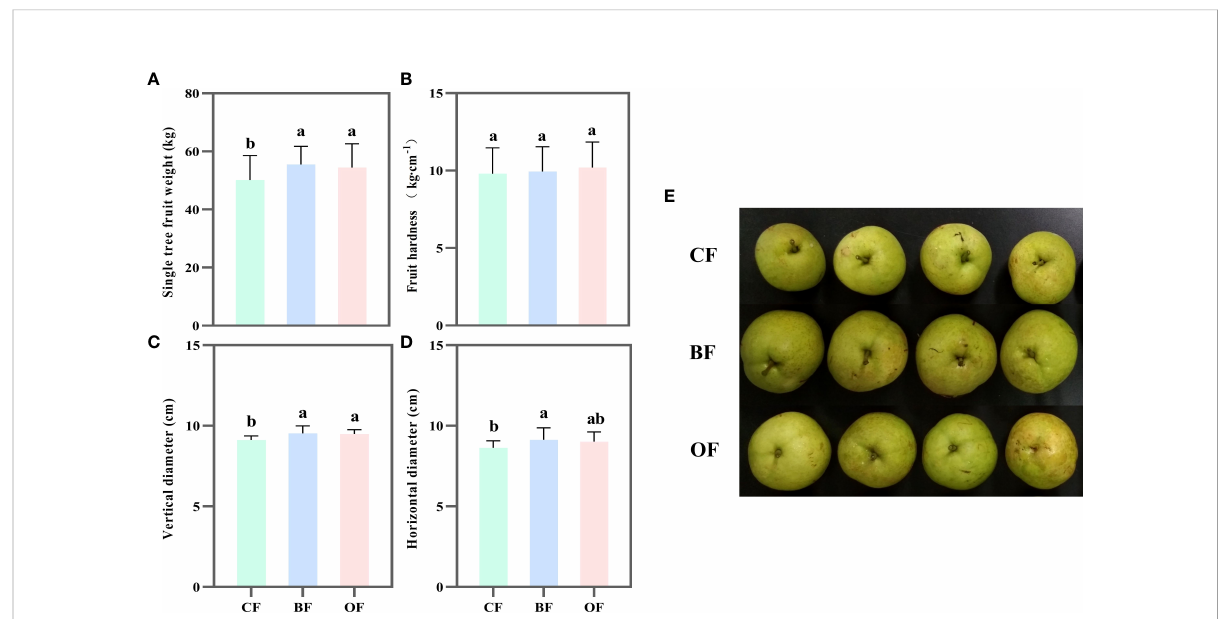
FIGURE 1 Effect of different fertilization treatments on fruit weight per tree (A) , fruit hardness (B) , fruit vertical (C) , horizontal (D) diameter and phenotype (E) of Pear. CF: chemical fertilizers application; BF: bio-organic fertilizers application; OF: organic fertilizers application. Values followed by different letters differ signi fi cantly (Duncan ’ s test, P < 0.05,